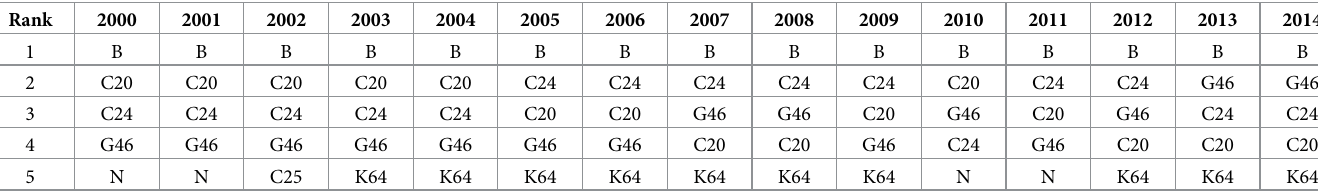
Table 11. Five highest-potential sectors in the Pacific Rim community. Rank